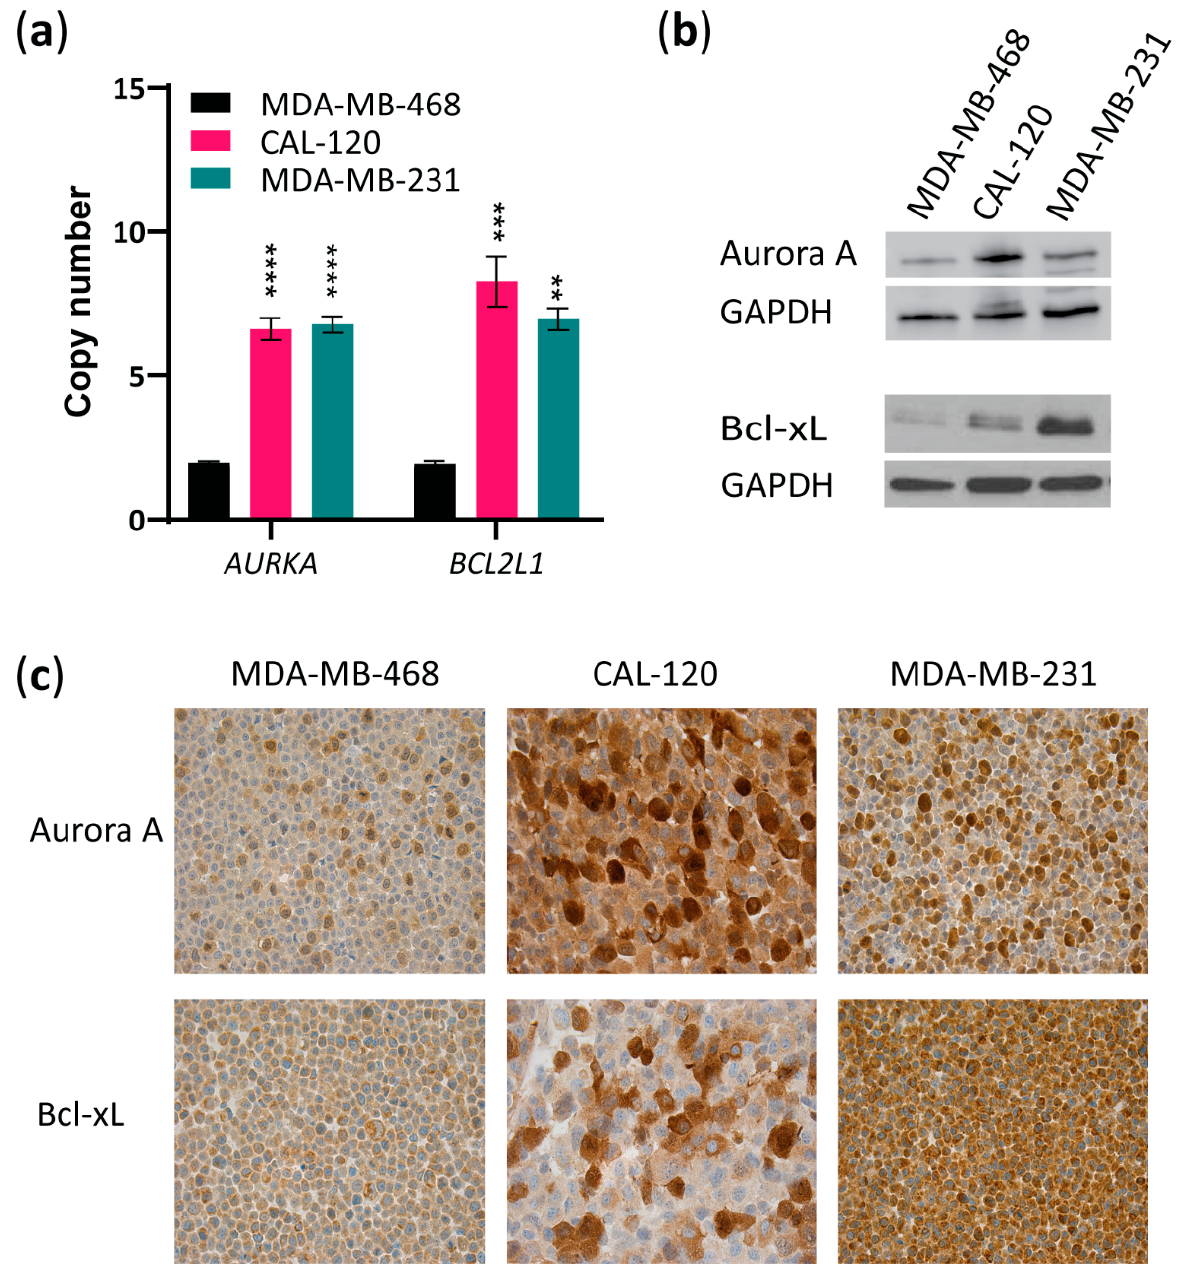
Figure 2. Basal B TNBC cells exhibit amplification of AURKA and BCL2L1 and overexpression of Aurora A and Bcl-xL. ( a ) Evaluation of AURKA and BCL2L1 gene copy numbers by quantitative RT-PCR copy number assay using TaqMan copy number variant (CNV) primers in basal A or B breast cancer cell lines. RNase P was used as reference. The data represent the mean of three biological replicates ± SEM. Statistically significant differences calculated by one-way ANOVA are shown as ns >0.05, ** p ≤ 0.01, *** p ≤ 0.001 and **** p ≤ 0.0001; ( b ) Western blot analysis of Aurora A and Bcl-xL in lysates from MDA-MB-468, CAL-120 and MDA-MB-231 cell lines. GAPDH was used as loading control. A representative of 2 biological replicates is shown; ( c ) Immunocytochemical analysis of FFPE basal A, MDA-MB-468 cells and basal B, CAL-120 and MDA-MB-231 cell lines, stained for Aurora A and Bcl-xL (×20).